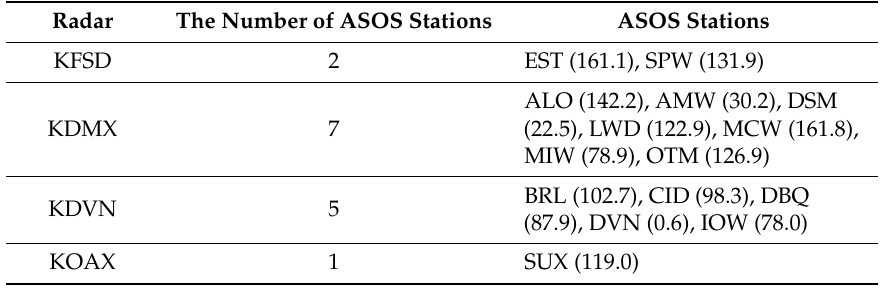
Table 1. Radar–ASOS pairs for matching precipitation classes and model input features retrieved from the radar data. The closest ASOS station was assigned to each individual radar, and the numeric values in parenthesis indicate the distance (km) between them.